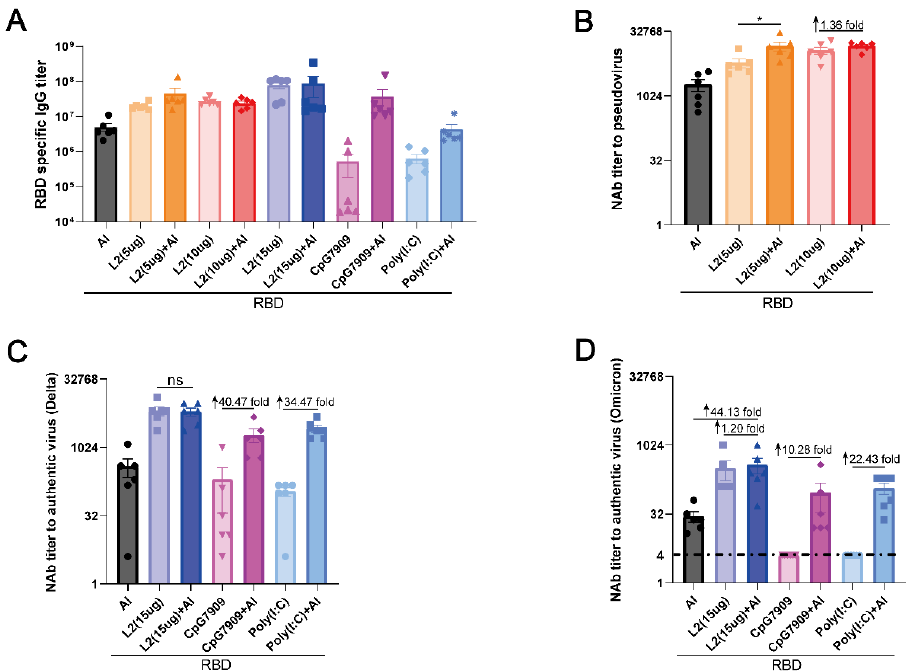
Figure Appendix A1. Low dose L2 plus Al improve the immunogenicity of RBD more effectively compared with Al, L2, CpG 7909 + Al, and Poly(I:C) + Al. ( A ) RBD-specific IgG titers. ( B ) NAb titers against pseudovirus. (C and D) NAb titers against authentic Delta and Omicron variants. ( C ) Delta variant. ( D ) Omicron variant. * p < 0.05. ↑ , increase. n = 6 for each group.